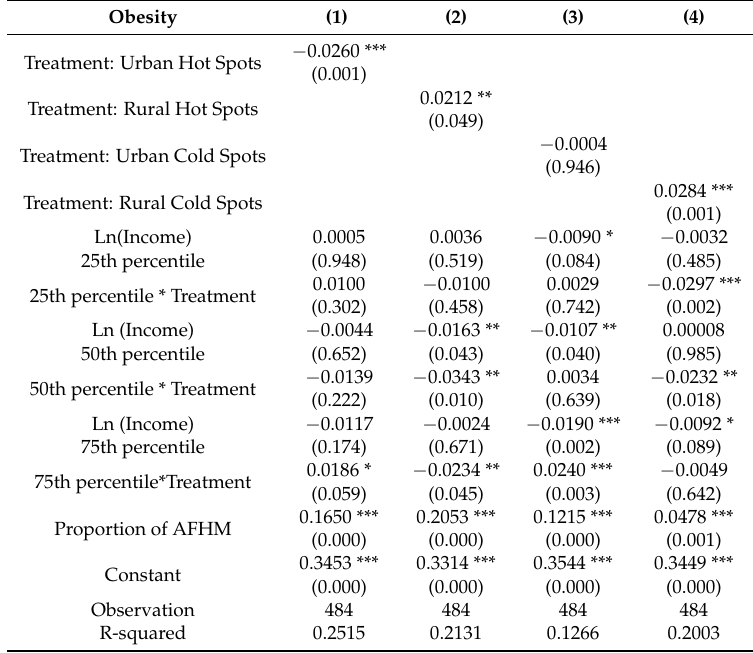
Table A10. The impacts of urban and rural hot (and cold) spots on obesity